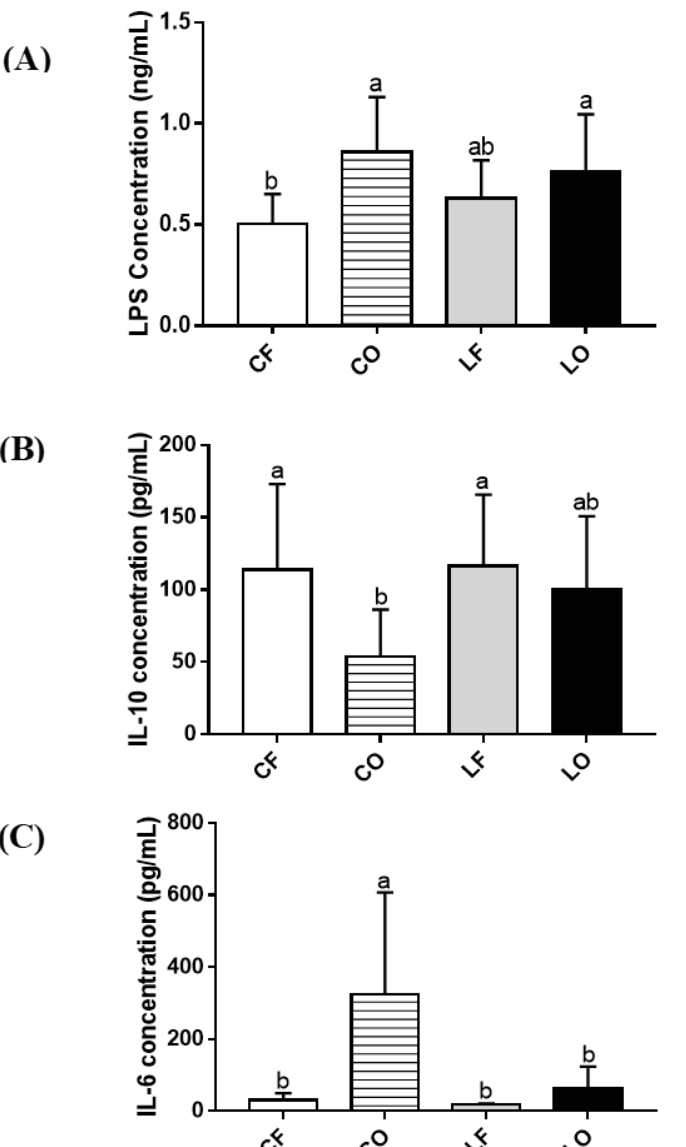
Figure 2. Concentration of ( A ) LPS; ( B ) IL-10; and ( C ) IL-6, in plasma of hamsters fed one of the four diets: CF, fresh corn oil; CO, oxidized corn oil; LF, fresh lard; LO, oxidized lard. Data are expressed as mean ± S.D., where different letters indicate statistical difference, p < 0.05.